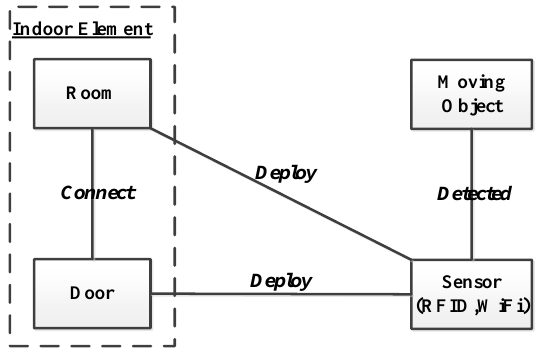
Figure 1. A simple model for indoor space.